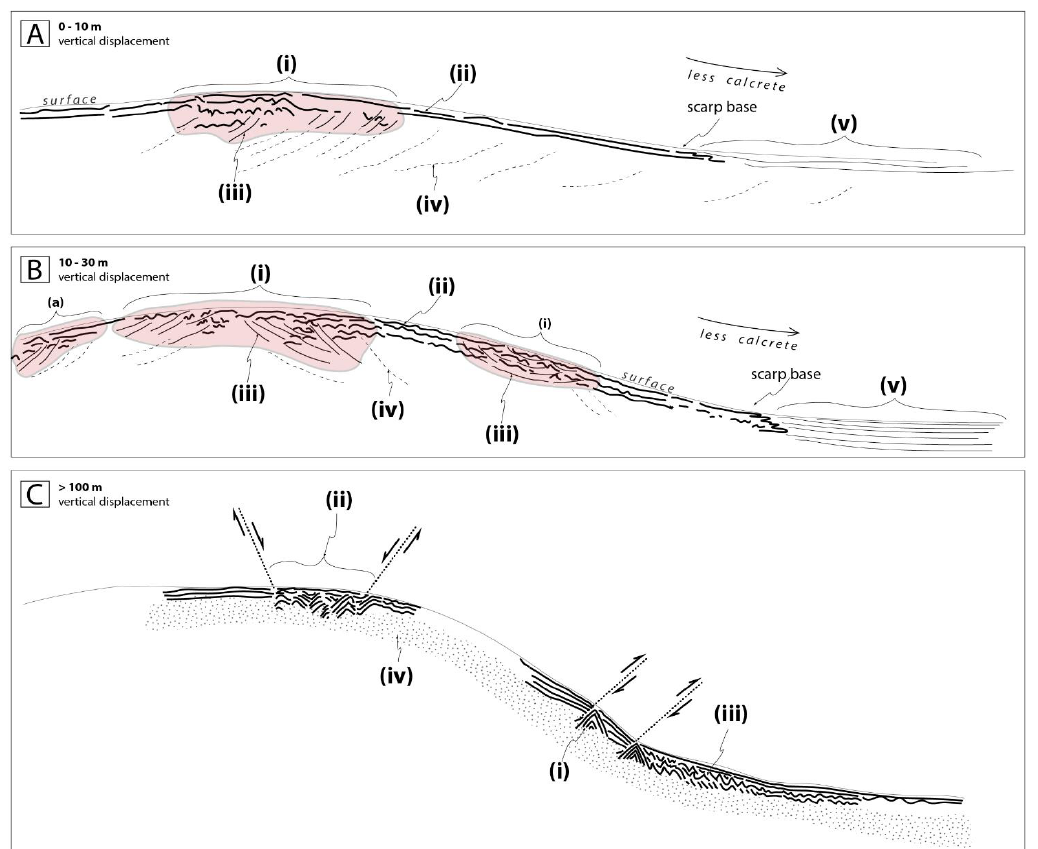
Figure 16. ( A , B ) — (i) zones of strong reflectors: surface parallel to sub-parallel reflectors, disrupted by hyperbolic diffractions, image calcrete (see (ii), while slightly weaker and inclined reflectors represent accentuated sedimentary stratigraphy (see (iii)). The strong reflectors imply increased contrast changes due to fracture-induced surface-water infiltration and, hence, alterations of the near-surface material. The spatial extend of these zones increases with accumulating displacement. (ii) strong, surface-parallel to sub-parallel reflectors imaging calcrete; (iii) primary sedimentary structure of local lithology, imaged as stronger reflectors where coseismic deformation has allowed increased water infiltration causing material alterations and hence, stronger contrast changes in the GPR signal response; (iv) primary sedimentary structure of local lithology, imaged as very weak reflectors; (v) weak, surface-parallel reflectors imaging beginning sedimentation at base of scarp. ( C )—(i) reverse faulting indicated by hyperbolic diffraction packages, thinning of reflector packages on the uplifted and thickening on the downthrown block; (ii) flexural graben indicated by zone of thickening, disturbed reflectors with numerous broken up hyperbolic diffractions; (iii) disturbed reflector packages incl. hyperbolic diffractions possibly indicating colluvium at the base of the scarp; (iv) zone of background noise, i.e., signal